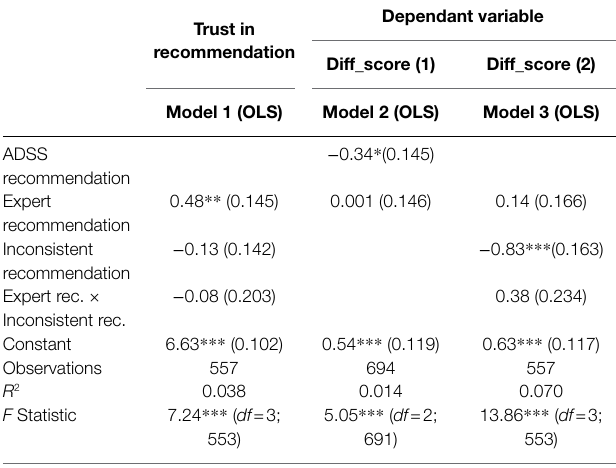
TABLE 1 | Impact of experimental conditions on trust and behavior (regression models).